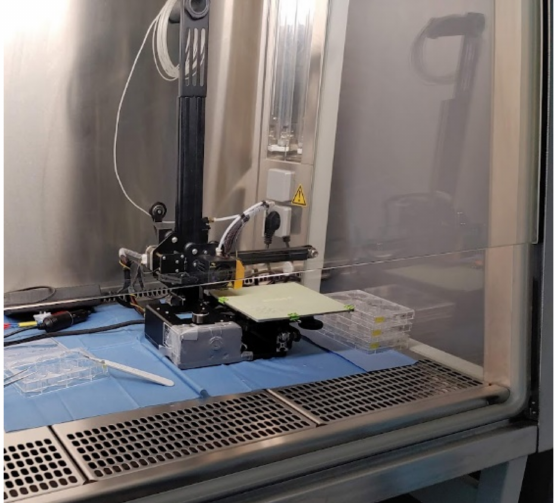
Figure 3. The printing setup for inherent sterility evaluation in sterile surroundings under the hood of a